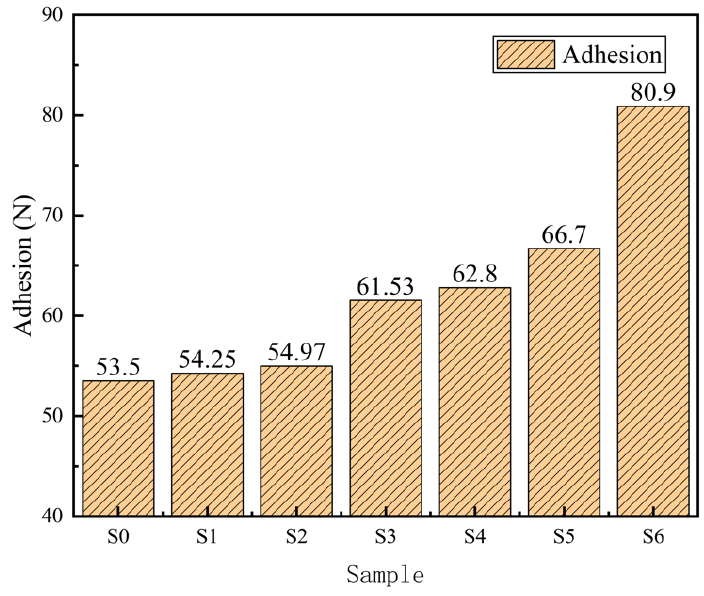
Figure 8. Adhesion force of MAO coating.